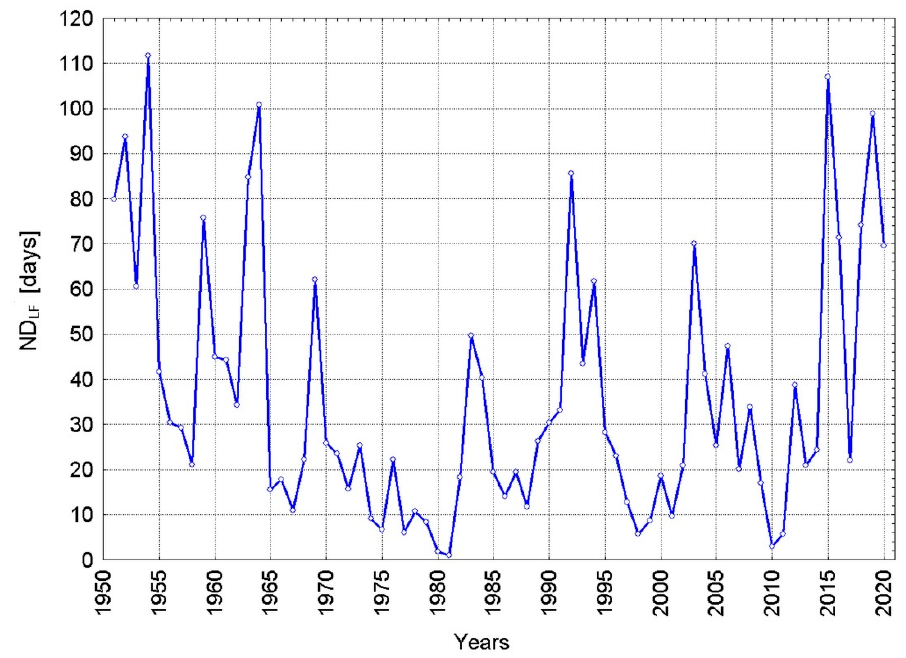
Figure 8. Course of the average number of days with low flows (ND LF ) in Poland in 1951–2020.